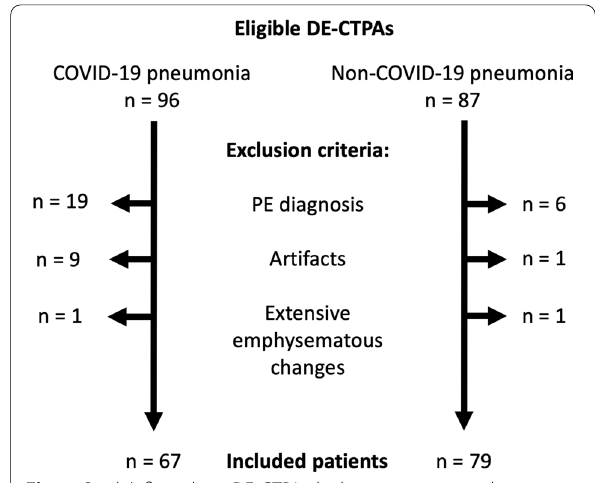
Table 1 Pneumonia types included in the non-COVID group Pneumonia type